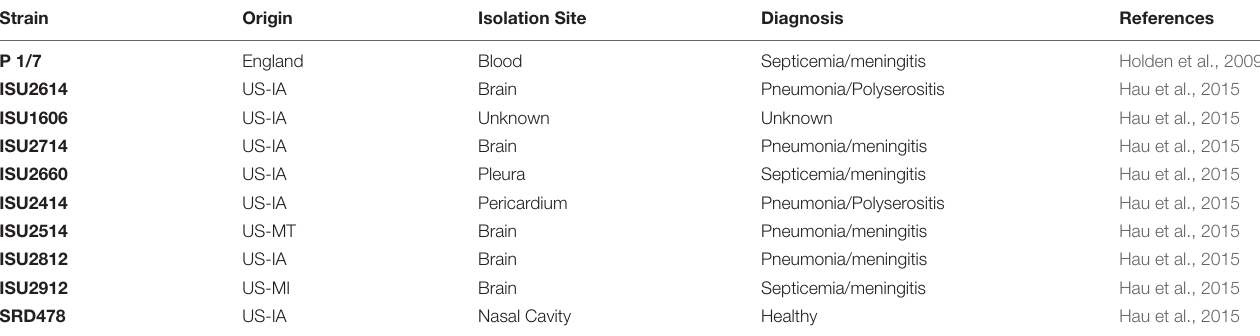
TABLE 1 | Isolation site, clinical diagnosis, and reference for the nine United States Streptococcus suis isolates and reference isolate used in this